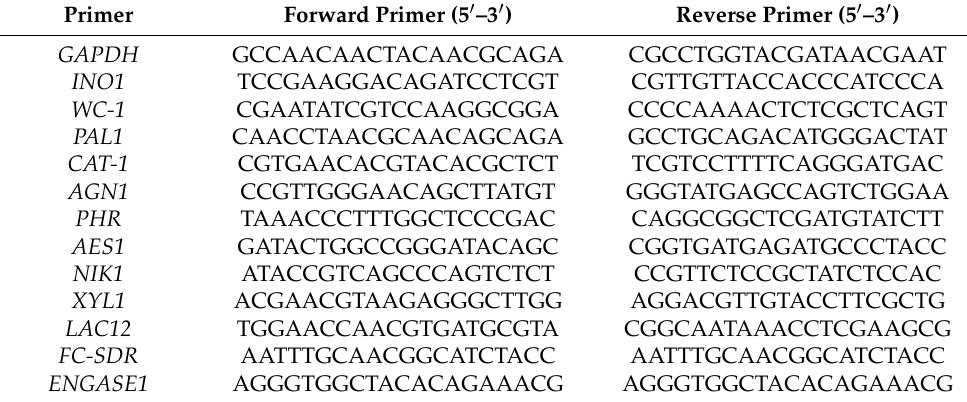
Table 2. Primers for